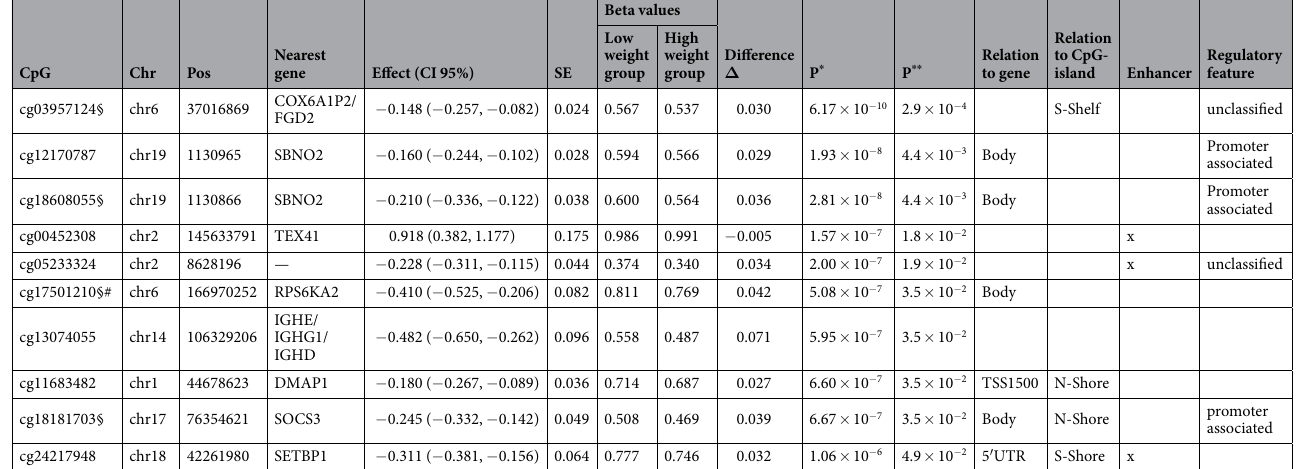
Table 2. Significant differentially methylated sites adjusted for covariates and cell composition. * Unadjusted p-values ** FDR adjusted p-values. § CpG sites identified by Wahl et al . 20 and # CpG site identified by Mendelson et al . 19 .